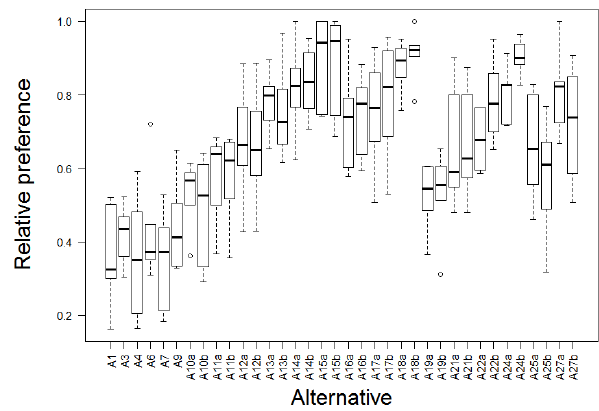
Figure 6. Standardised values of preferences of the alternatives by the stakeholders (min, median, 75th percentile, max).